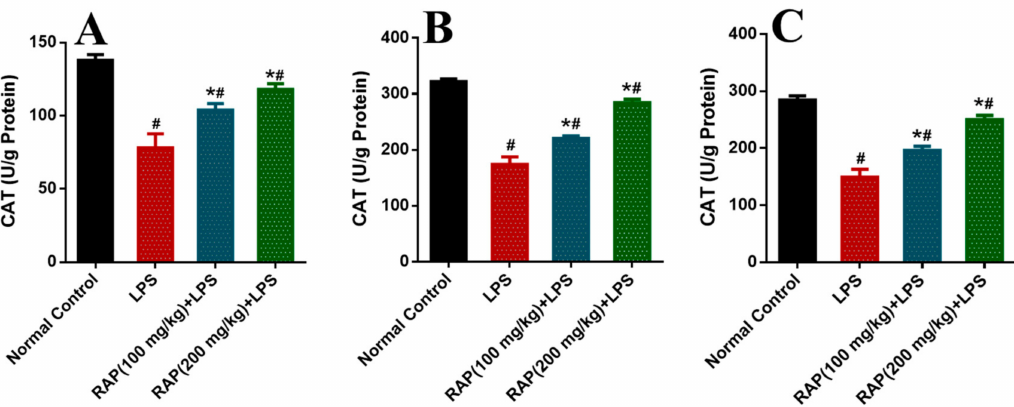
Figure 2. Determination of CAT in ( A ) plasma, ( B ) Liver and ( C ) Brain. Results are mean SEM of seven animals per group. ‘*’ denotes significant di ff erences compared with the normal control group ( p < 0.05); ‘#’ denotes significant di ff erences compared with the LPS group ( p <